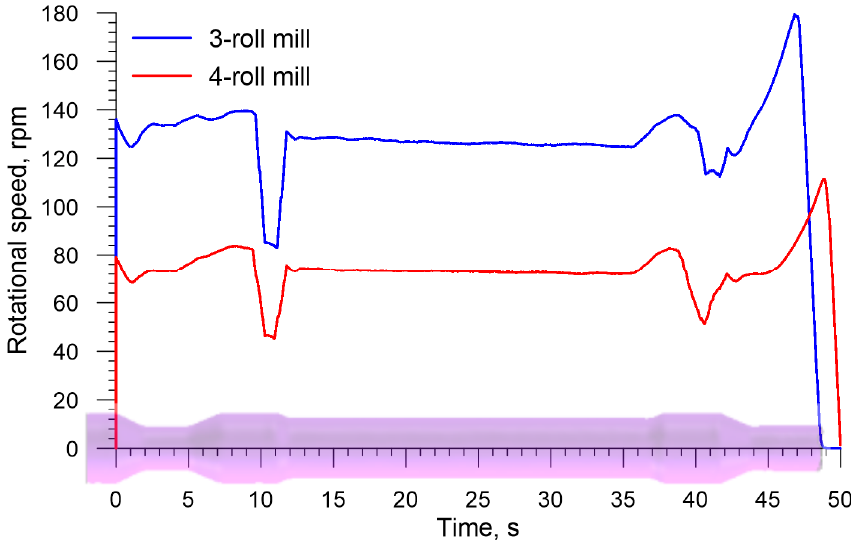
Figure 12. Rotational speed of the workpiece in skew rolling railway axles in 3- and 4-roll mills.